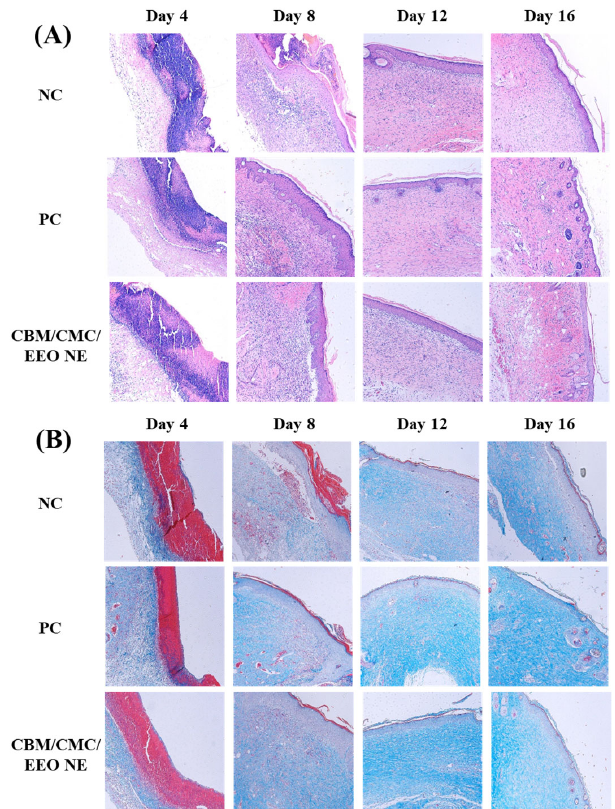
Figure 6. Histopathological stained sections of traumatic tissue of different groups within 16 days. ( A ) H&E stain; ( B ) Masson’s stain.